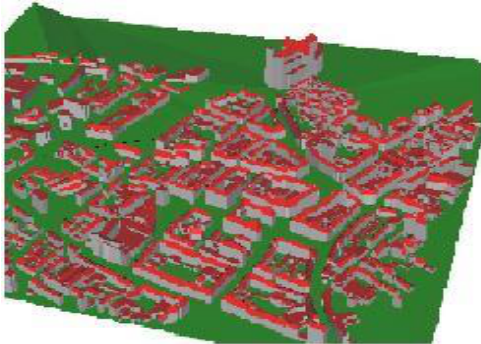
Fig.2. 3D City model (Source- Flamanc et al.,